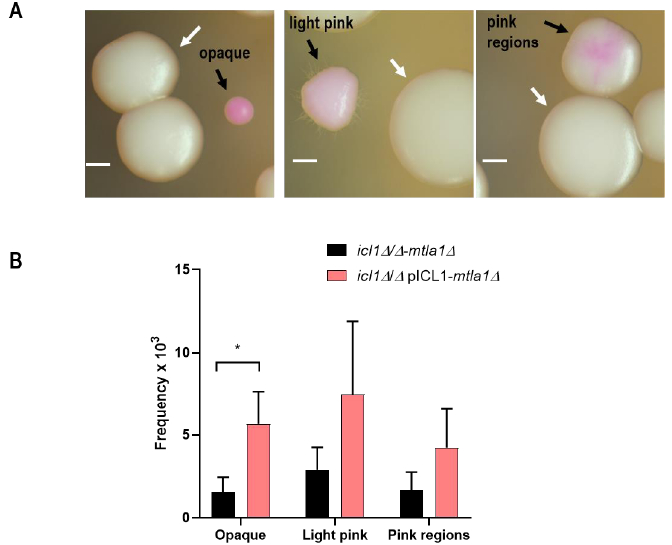
Figure 4. Induction of white-opaque conversion in icl1 Δ / Δ -mtla1 and icl1 Δ / Δ / ICL1-mtla1 strains. 300 CFUs were spread onto YPD pH = 6 plates supplemented with 5 µg/mL phloxine B and incubated in the dark for 2 days at 28 °C and 5% CO 2 . The upper picture ( A ) indicates the appearance of the different counted colonies as standard white colonies (white arrows) or pink colored colonies (black arrows), either opaque, light pink, or mixed colored colonies (pink regions) in icl1 Δ / Δ -mtla1 . White scale bar stands for 1 mm. Data ( B ) are shown as mean with standard deviation (SD) from six inde- pendent experiments ( n ≈ 2500 colonies from each strain per experiment). The frequency (colonies of the indicated type/1000 total colonies) is represented. A t -test was used to determine the signifi- cance ( p = 0.021, * p < 0.05).